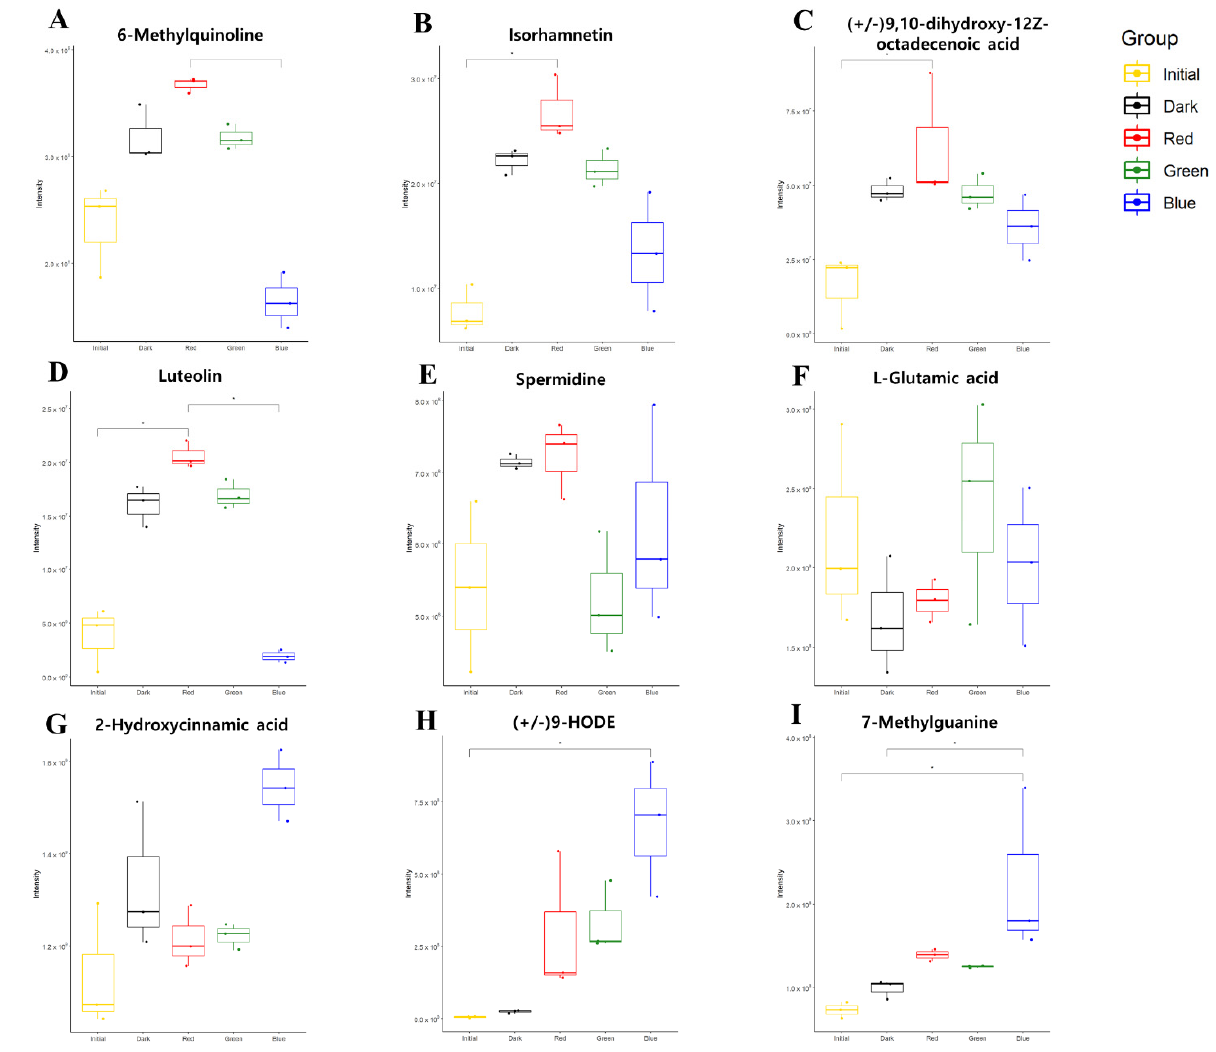
Figure 5. The relative abundances of the metabolites with characteristic alteration identified based on the OPLS-DA model. The abundances (ion intensities) are shown as box-whisker plot. p value is estimated based on Kruskal–Wallis test and Dunn’s test adjusted by Benjamini–Hochberg correction. * indicates p < 0.05. ( A – D ) are metabolites significantly altered in RLED group. ( E , F ) are metabolites significantly altered in GLED group. ( G – I ) are metabolites significantly altered in BLED group.